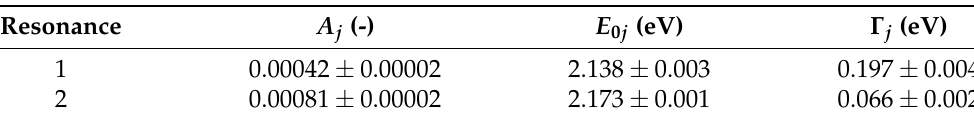
Table 3. Gaussian parameters and corresponding confidence limits for κ for the cuticle of C. aurata (sample